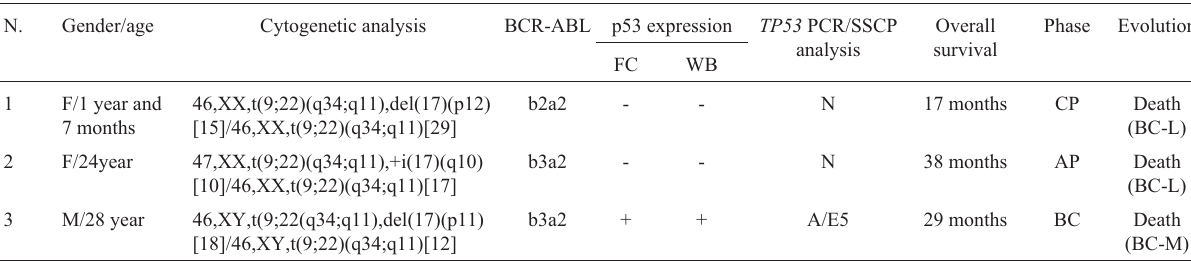
Table 1 - Clinical characteristics and cytogenetic and molecular analyses of the patients. N.